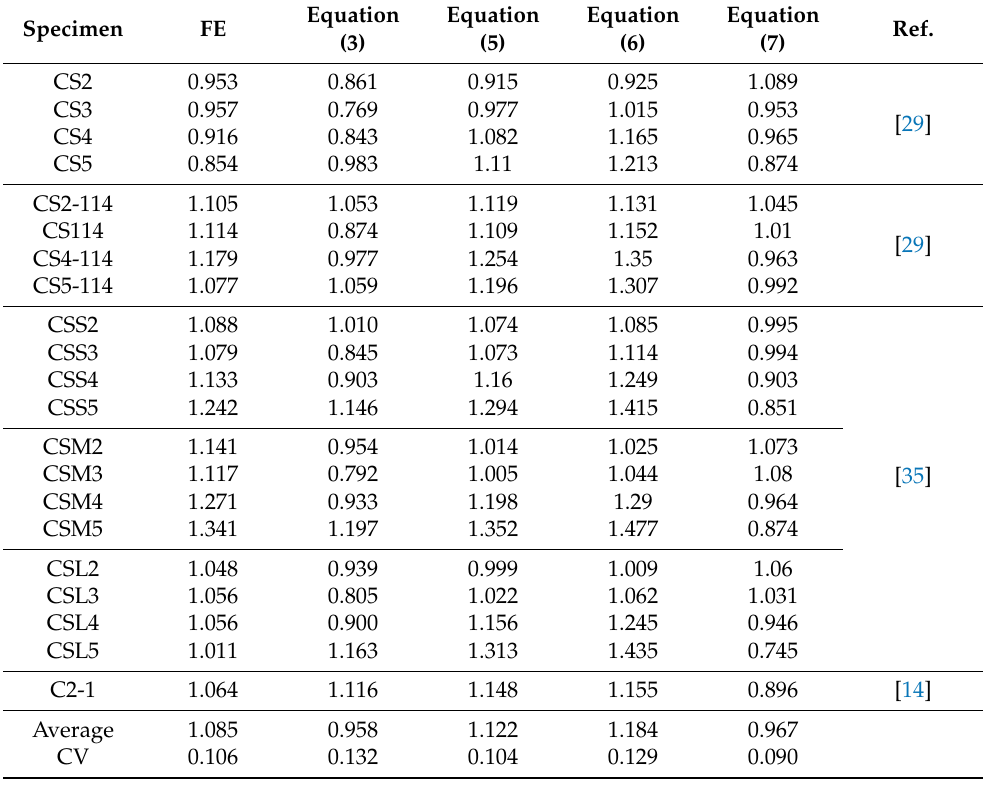
Table 3. Comparison of different calculation formulas.